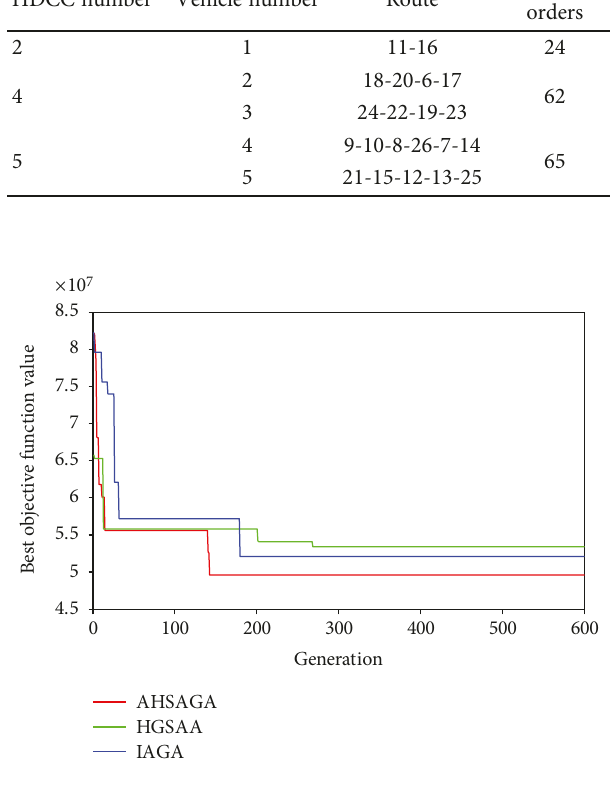
Table 5: Initial HDCC locations and vehicle routes. HDCC number Vehicle number